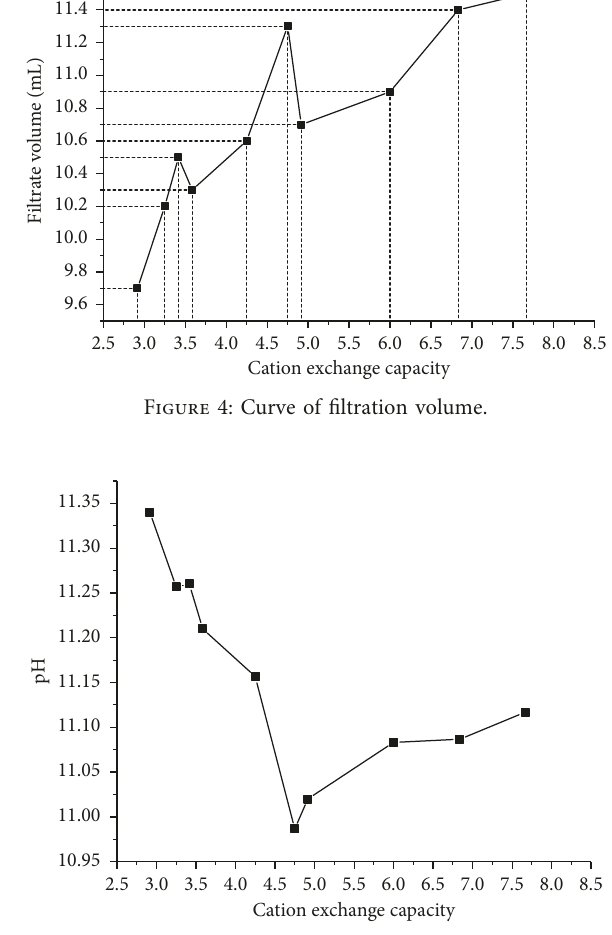
Figure 5: Curve of pH change in the slurry